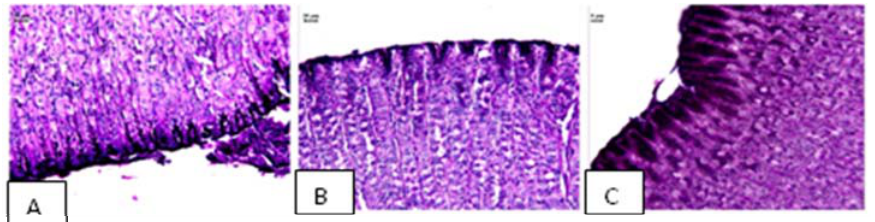
showing mucus in (A) normal epithelium; (B) loss of epithelial mucus in Tween treatment and (C) presence of epithelial mucus after AcF treatment.